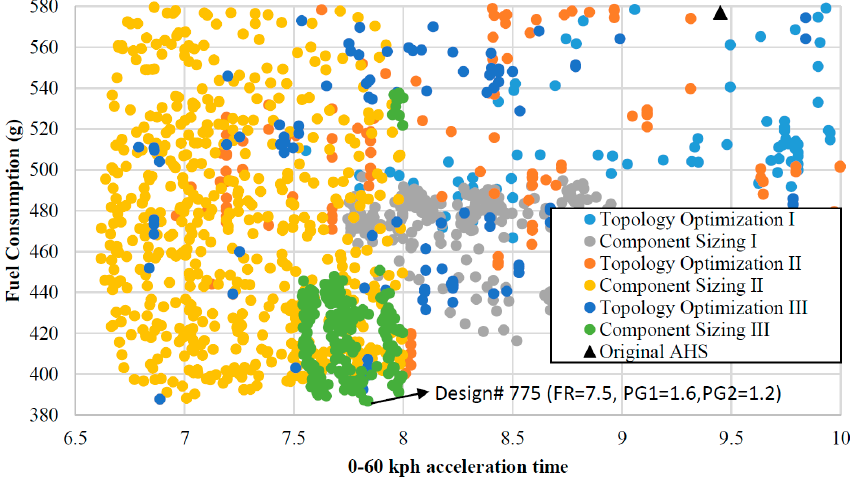
Figure 9. Results of each optimization for initial point (FR = 6, PG1 = 1.5, PG2 = 3).